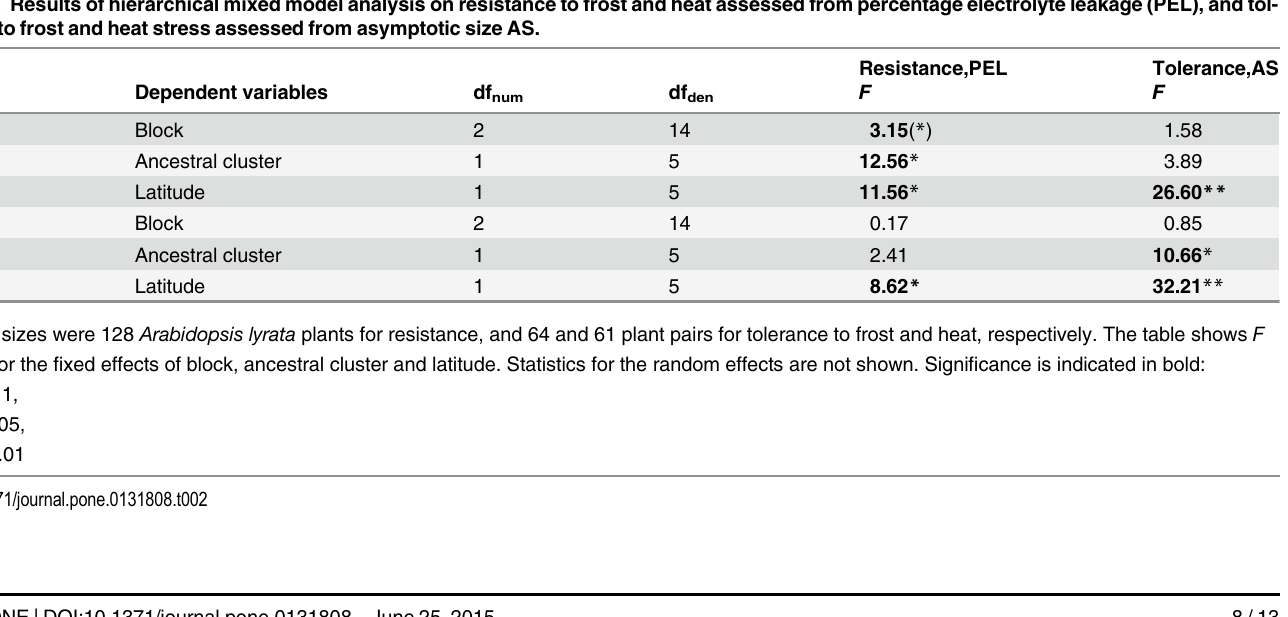
Table 2. Results of hierarchical mixed model analysis on resistance to frost and heat assessed from percentage electrolyte leakage (PEL), and tol- erance to frost and heat stress assessed from asymptotic size AS.